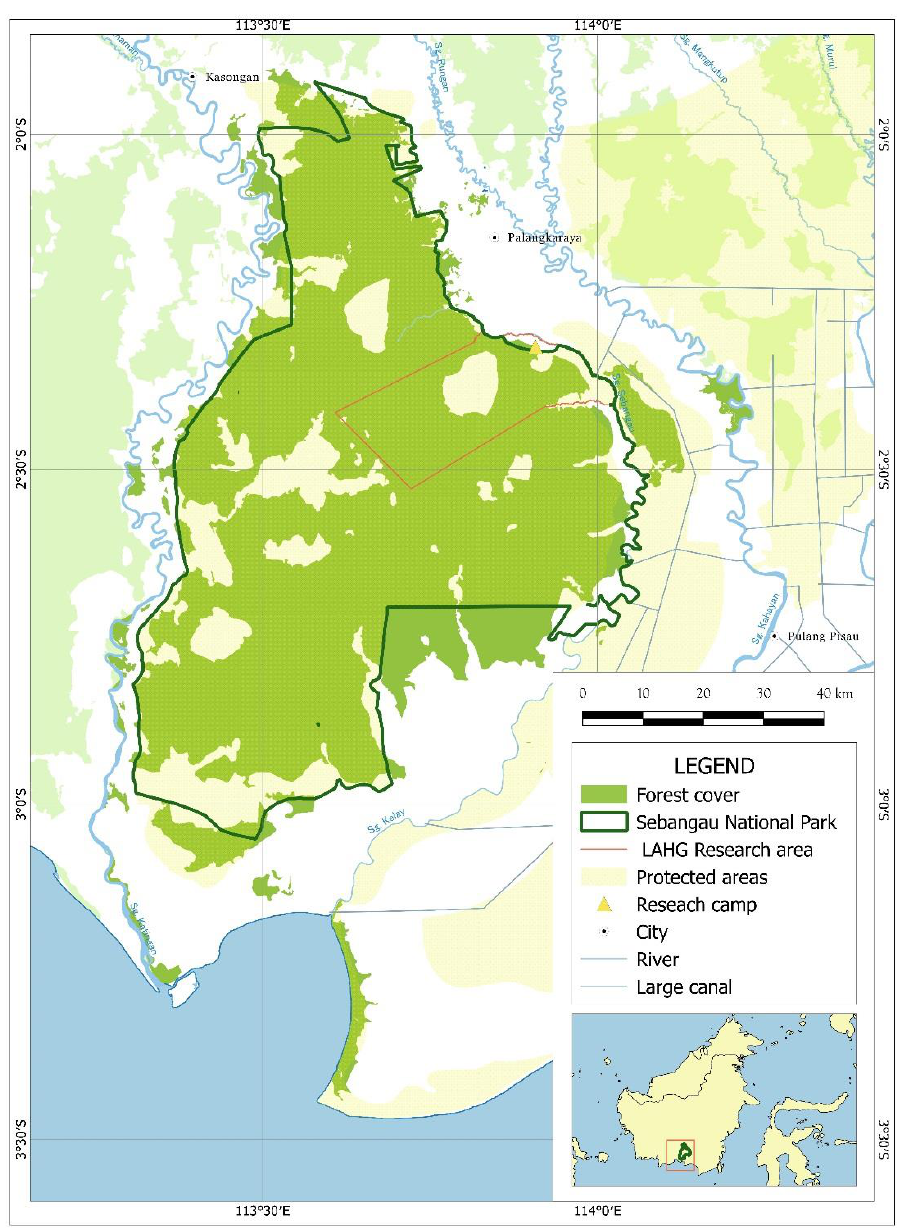
Figure 1. Location map. The seed bank samples were collected slightly to the west of the research camp (yellow triangle), within the NLPSF study site area or LAHG research area (red line), shown in relation to the island of Borneo (inset). Image courtesy of B. Ripoll